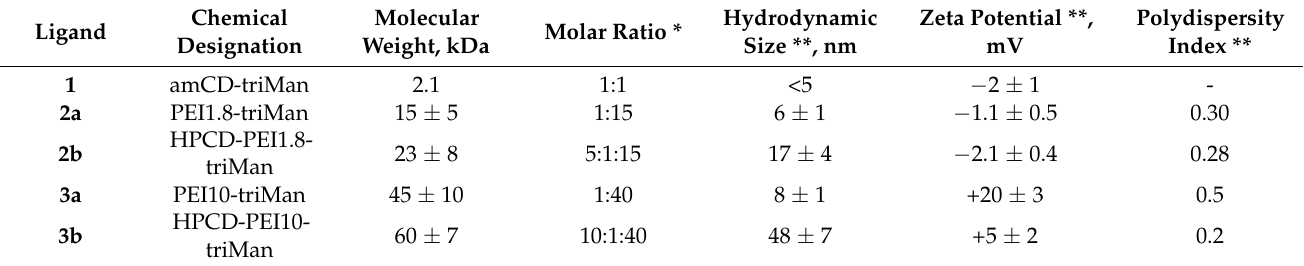
Table 1. Physico-chemical properties of mannosylated